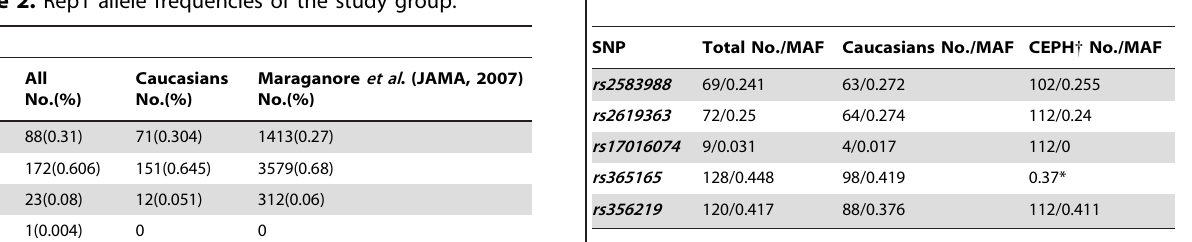
Table 2. Rep1 allele frequencies of the study group.